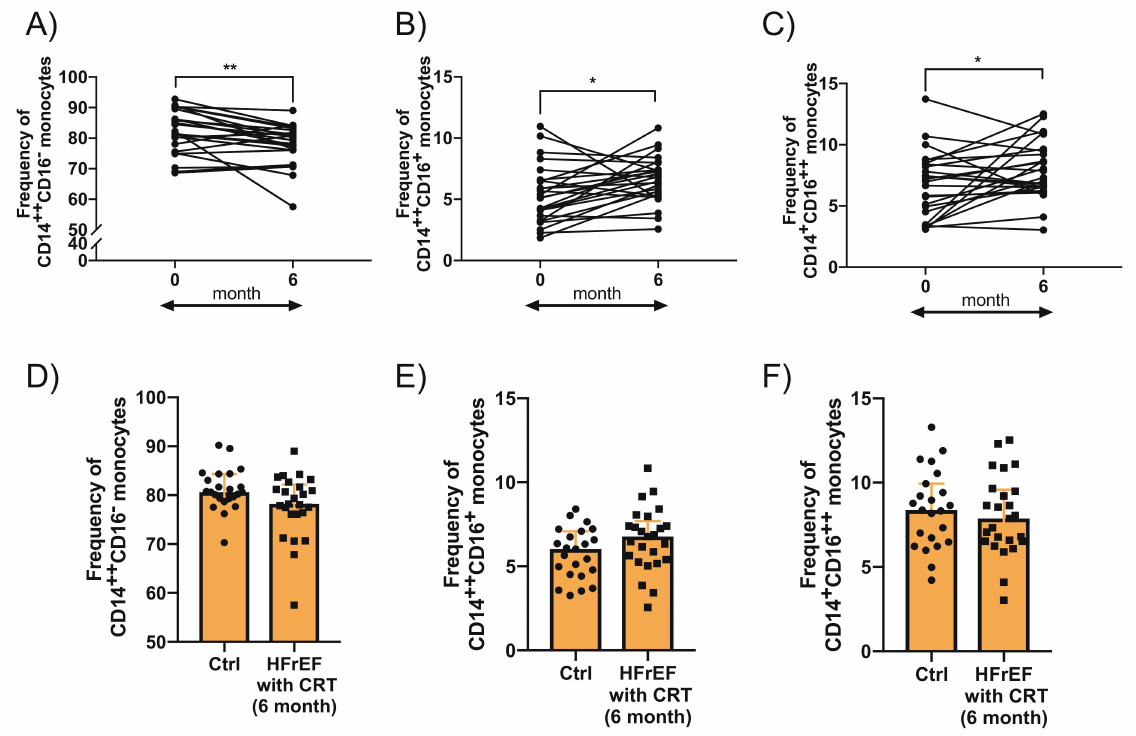
Figure 3. Monocyte subsets in patients with heart failure with reduced ejection fraction (HFrEF) who qualified for cardiac resynchronization therapy (CRT) at baseline (0) and at 6-month follow-up (6). ( A ) classical (CD14 ++ CD16 − ) ( B ) intermediate (CD14 ++ 16 + ), and ( C ) nonclassical (CD14 + 16 ++ ) monocytes. Monocyte subsets in 6-month follow-up after CRT device implantation compared to controls ( D ) classical (CD14 ++ CD16 − ) ( E ) intermediate (CD14 ++ 16 + ), and ( F ) nonclassical (CD14 + 16 ++ ) monocytes.* p < 0.05; ** p <